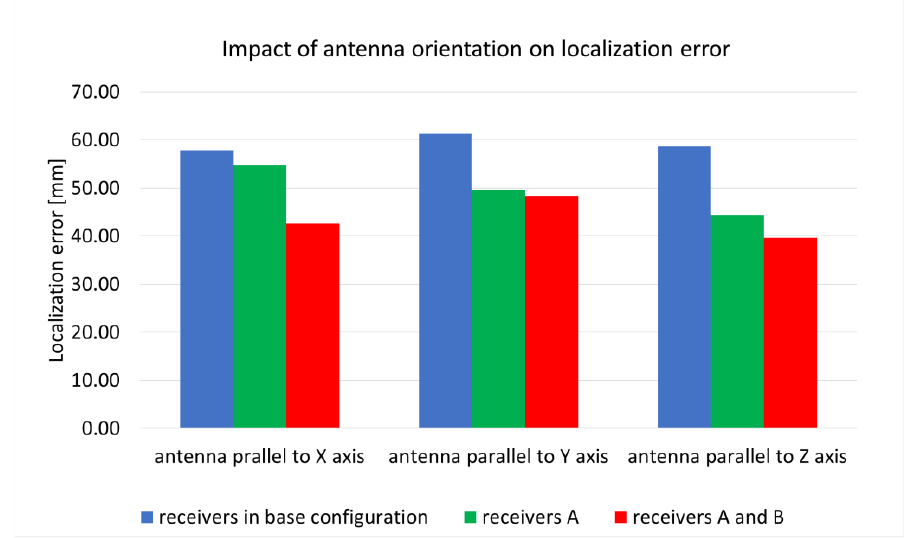
Figure 20. Impact of antenna orientation on localization error.